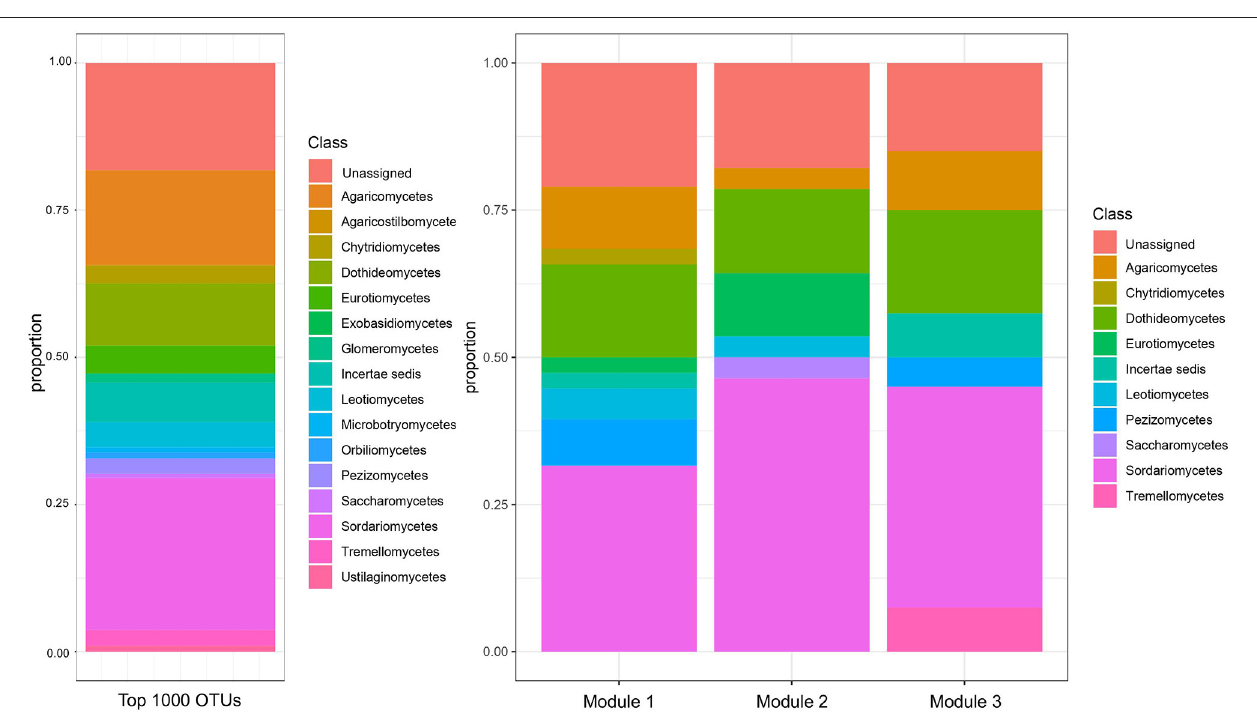
FIGURE 4 | Taxonomic composition, by class, of the top 1000 ITS OTUs and of the three modules of ITS OTUs identified by WGCNA. The threshold of top 1000 OTUs was applied for the subsequent WGCNA analysis.